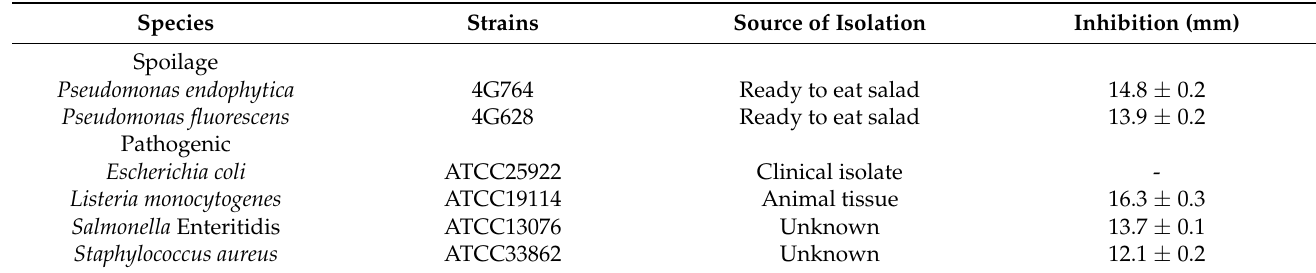
Table 3. Antibacterial activity of O. ficus-indica mucilage edible coating.